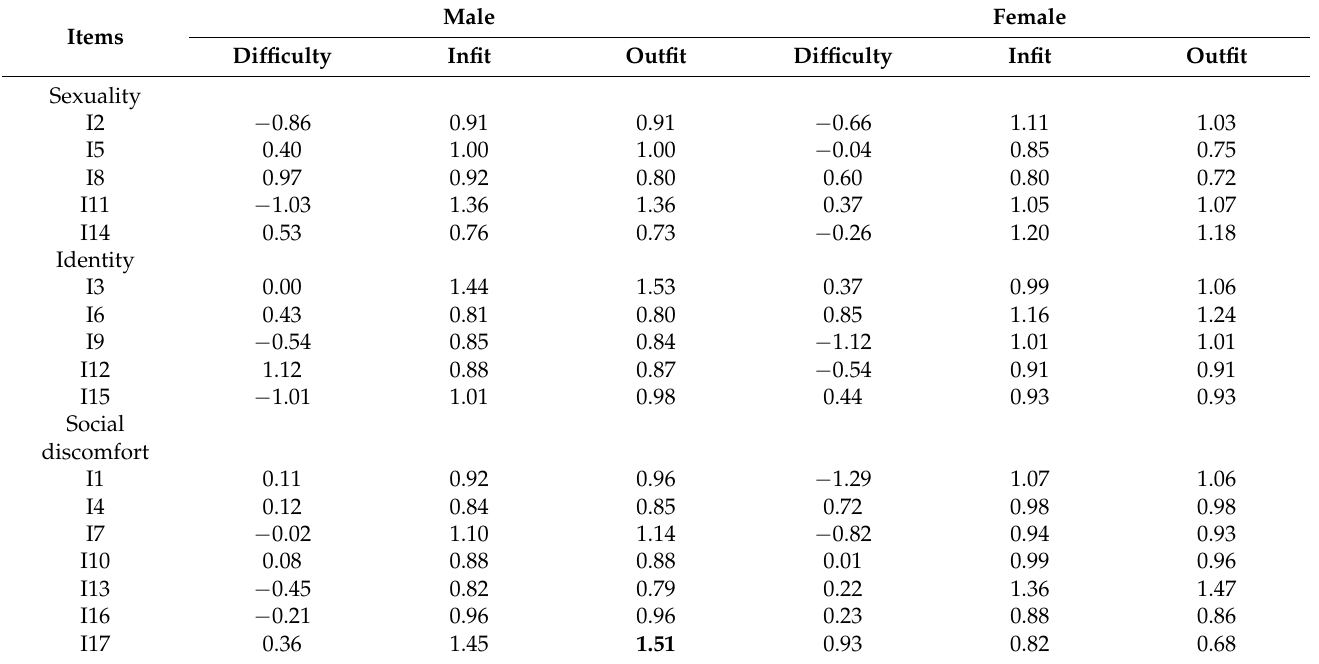
Table 3. Rasch analysis results for the Measure of Internalized Sexual Stigma for Lesbians and Gay Men (MISS-LG). Male Female Items Infit Outfit Difficulty Infit